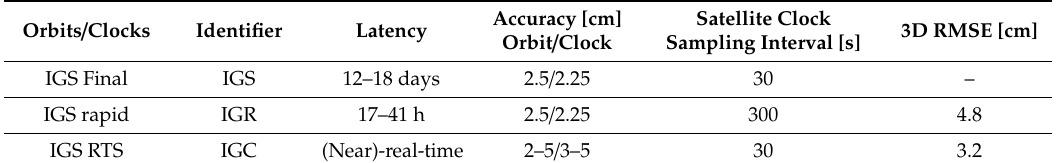
Table 4. Information on di ff erent IGS products and the 3D orbital RMSE using 10 s observation